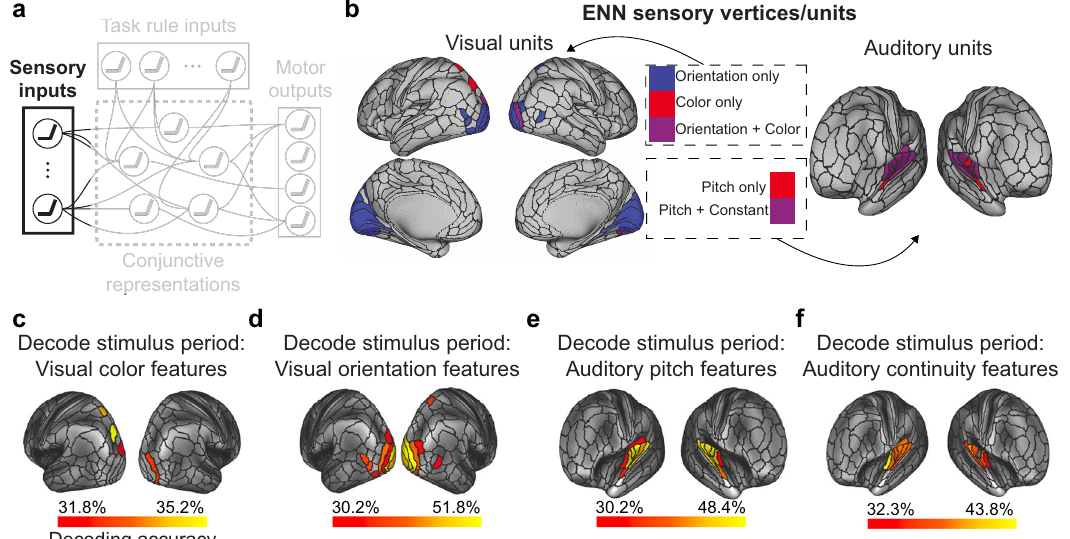
Fig. 3 Identifying sensory stimulus input units (vertices) of the ENN using an fMRI decoding analysis. a We identi fi ed the sensory stimulus representations in empirical data using fMRI pattern decoding of stimulus activations. This corresponded to the sensory input component of the Guided Activation Theory. To decode visual features (i.e., color and orientation stimulus features) we decoded the vertices within each parcel in the visual network using a recent functional network atlas 65 . To decode auditory features (i.e., pitch and continuity) we decoded the vertices within each parcel in the auditory network (see Methods). b The ENN sensory units, which were derived from a mask of the vertices that could successfully decode stimulus features (panels c – f ). c Decoding of color features using task activation estimates (from a task GLM) during the stimulus presentation period of the C-PRO task. Chance was 25%; cortical maps were thresholded using an FDR-corrected threshold of p < 0.05. d Four-way decoding of orientation features. e Four-way decoding of auditory pitch features. f Four-way decoding of auditory continuity